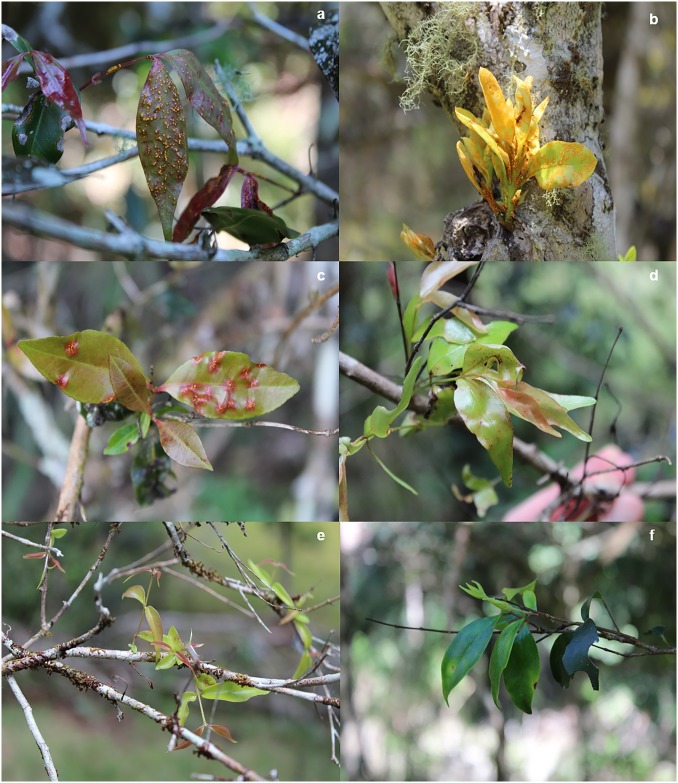
Symptoms of Austropuccinia psidii infection of epicormic/reshooting young foliage of (a) Rhodamnia maideniana, (b) Syzygium corynanthum, (c) Syzygium hodgkinsoniae, (d) Gossia hillii, (e) Decaspermum humile and (f) Archirhodomyrtus beckleri.